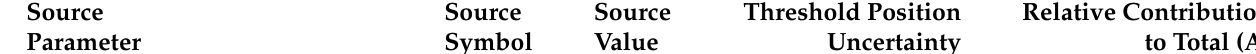
Table 1. Overview of all investigated sources of uncertainty converted to distance between detected and true threshold position and their relative contributions to the total variance σ 2 ∆